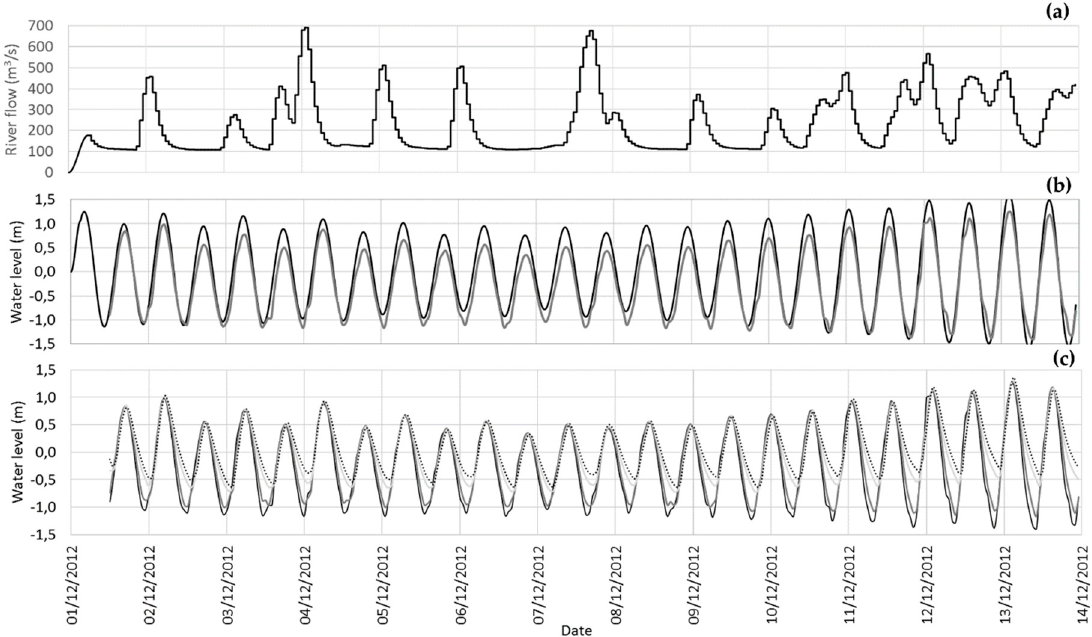
Figure 7. Scenario S2: boundary conditions and time series at the numerical tidal gauges. Time from 1 December 2012 00:00 h UTC. ( a ) River flow rate at the upstream boundary; ( b ) tidal level at the ocean boundary (—) and water level at the numerical gauge T1 ( — ); and ( c ) water level at the numerical gauges: T1 ( — ); T2 ( — ); T3 (—); T4 ( … ); T5 ( … ).